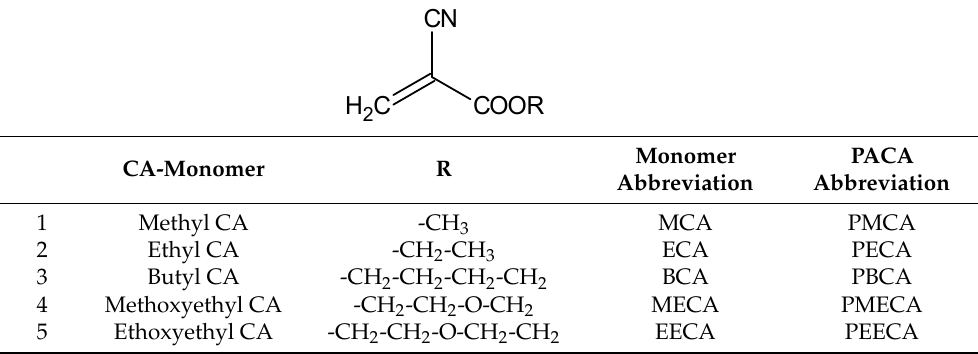
Table 1. Chemical structures and abbreviations of used cyanoacrylate (CA) materials.